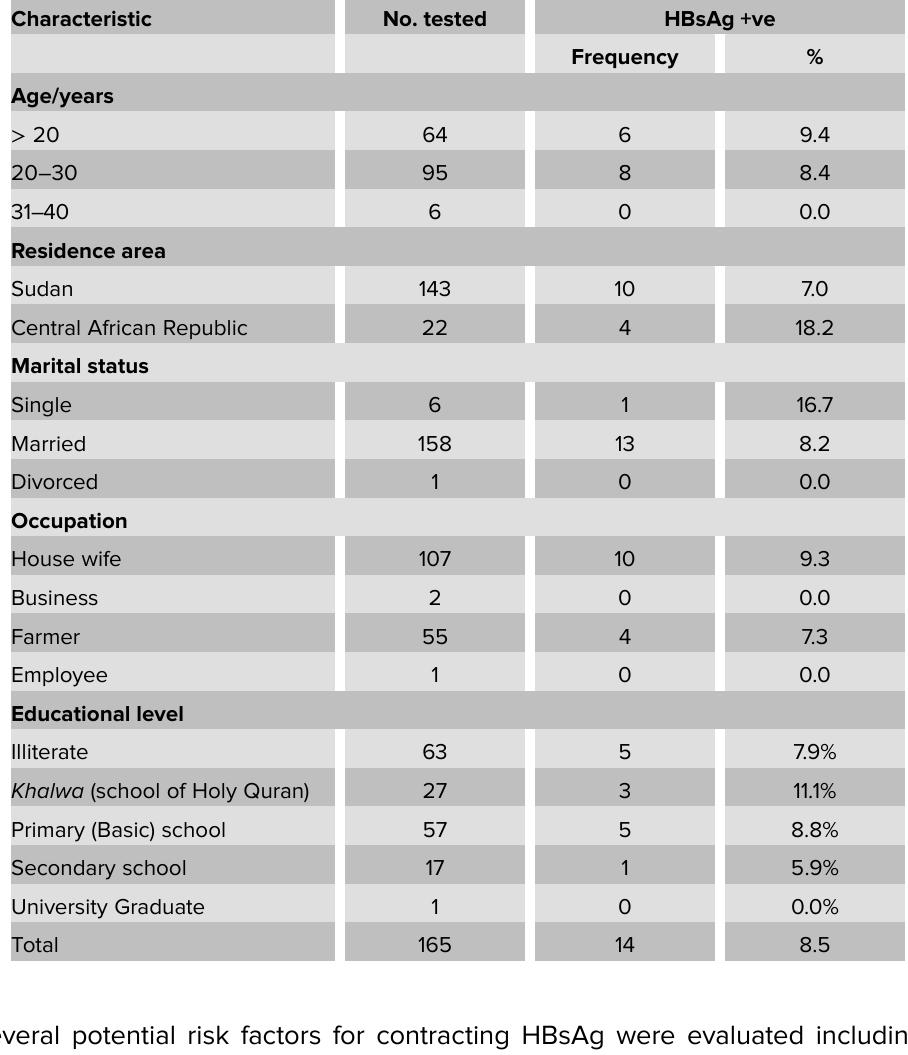
Table 1: Distribution of HBsAg-positive pregnant women according to their socio-demographic